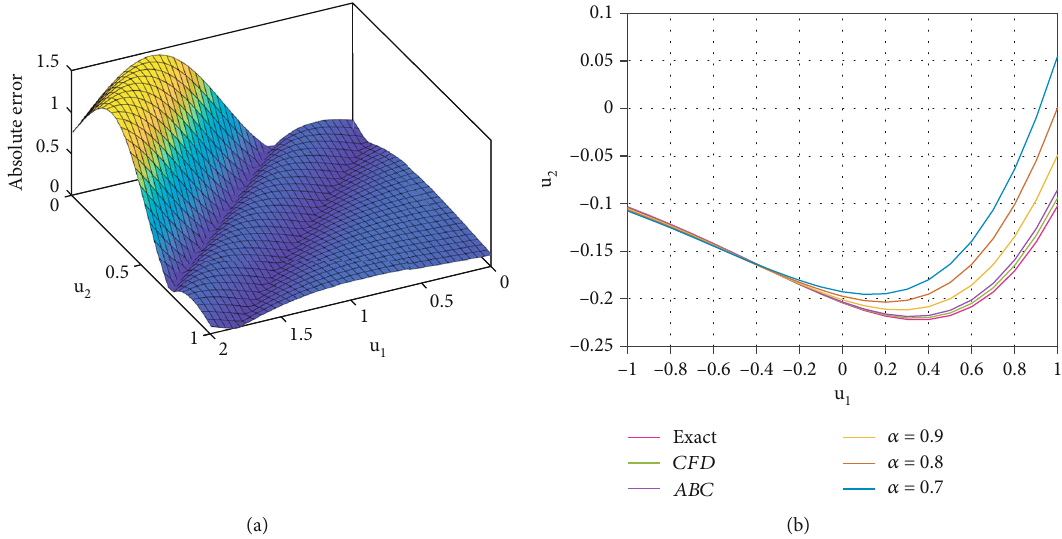
Figure 7: (a) 3D view of absolute error for f ð u when t = 0 : 7 :